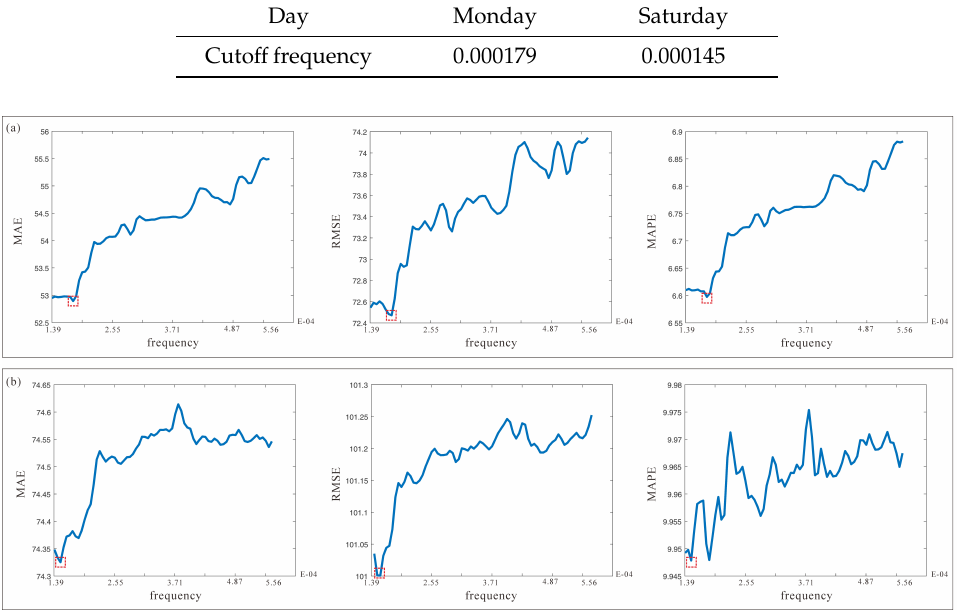
Figure 11. MAE and RMSE values for the cuto ff frequencies from low_fs to fs : ( a ) values on a